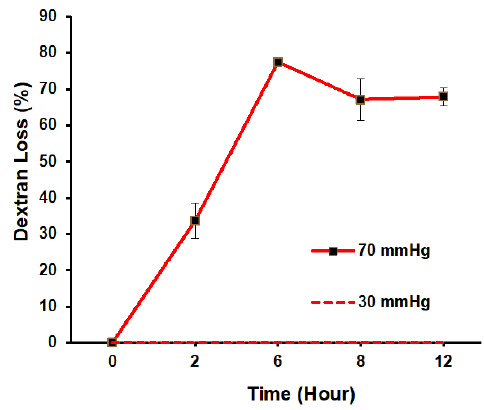
Figure 6. Podocyte filtration function. Δ P of 30 mmHg and 70 mmHg were applied for 6 h, followed by 10 mmHg for the following 6 h to investigate the recovery of filtration function. Data are shown as mean ± SD ( n = 3).